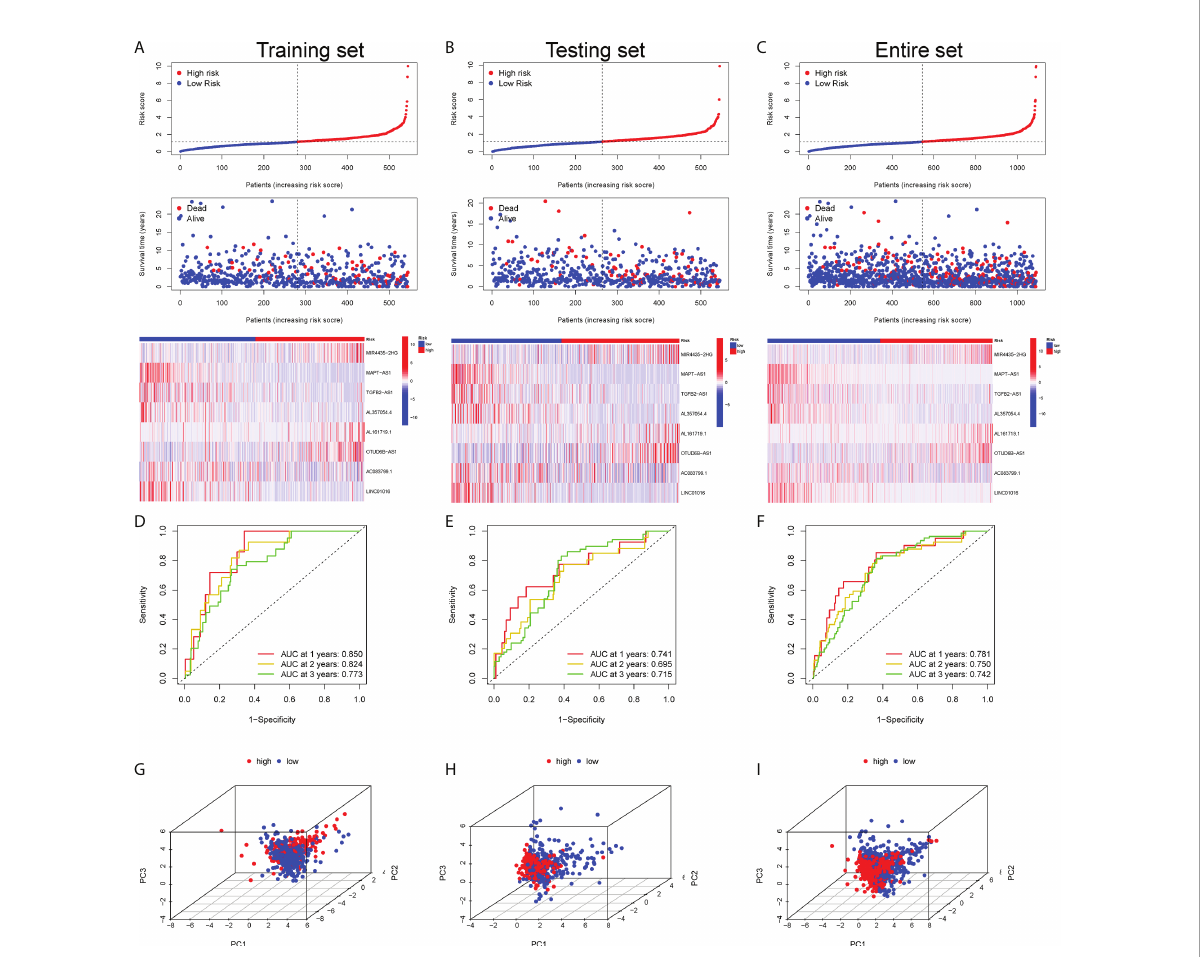
FIGURE 2 Prognostic validation of the risk score in the training, testing and entire set. The scatter plot of every sample and the heatmap of the expression pro fi les between two risk subgroups in the training set (A) , testing set (B) and entire set (C) . The AUC value of the risk score at 1-, 2- and 3-year survival in the training set (D) , testing set (E) and entire set (F) . The PCA visualizing the distribution pattern of the high- and low-risk patients in the training set (G) , testing set (H) and entire set (I)